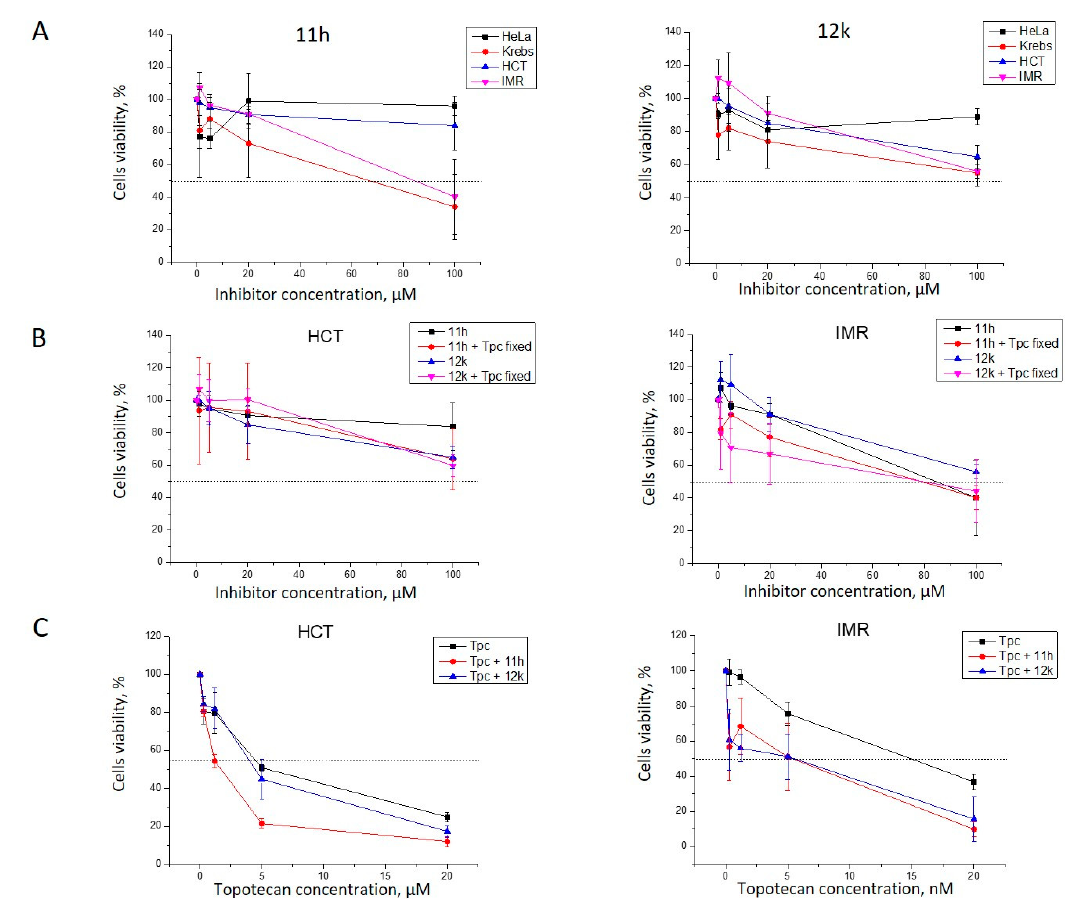
Figure 4. Activity of 11h and 12k with topotecan (Tpc) against tumor cells ( A ). The intrinsic cytotoxicity of 11h and 12k derivatives on the cancer cell lines ( B ). Dose-dependent action of 11h and 12k in combination with Tpc ( C ). Dose-dependent action of Tpc in conjunction with 11h and 12k . The intrinsic cytotoxicity of both 11h and 12k on HeLa (cervical carcinoma), HCT116 (human colon cancer), IMR-32 (human neuroblastoma cell line), and Krebs-2 carcinoma cells was low (Figure